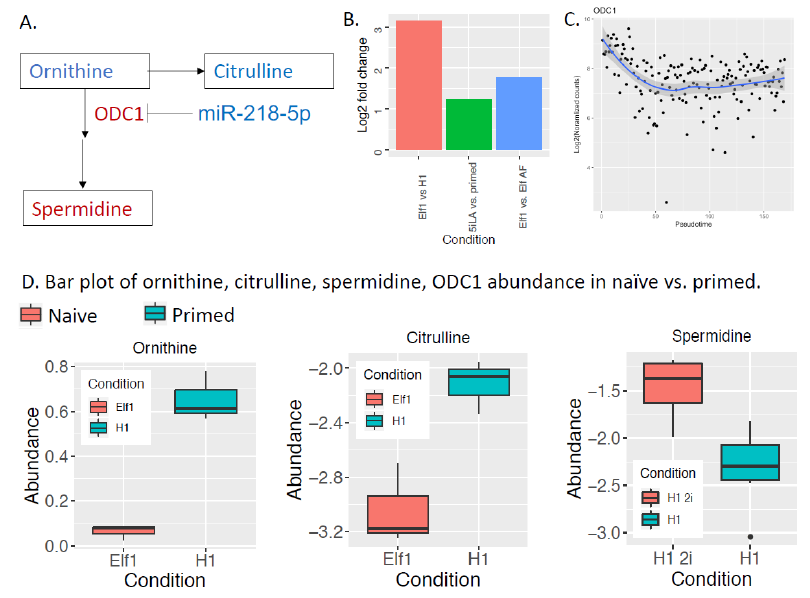
Figure 3. The polyamine pathway is dysregulated in naïve to primed transition: ( A ) Ornithine is converted to polyamines (spermine and spermidine) by the rate limiting enzyme ornithine decarboxylase (ODC1). ODC1 is consistently up-regulated in the naïve state, and its microRNA regulator, miR-218-bp, is lower in the naïve state. Each rectangle box is a metabolite; each arrow is a reaction. Red means higher abundance in naïve state; blue means lower abundance in naïve state. “--|” (T-bar) indicates repression of ODC1 by miR-218-5p. ( B ) Log2 fold change of ODC1 in three separate naïve vs. primed cell line comparisons. ( C ) ODC1 expression changes in monkey pre-to-post-implantation transition in vivo. ODC1 is also expressed higher in the naïve state in vivo . Blue line represents a local regression fit of the data ( D ) Bar plot of ornithine, citrulline, and spermidine abundance in naïve (Elf1, H12i) and primed (H1) cell